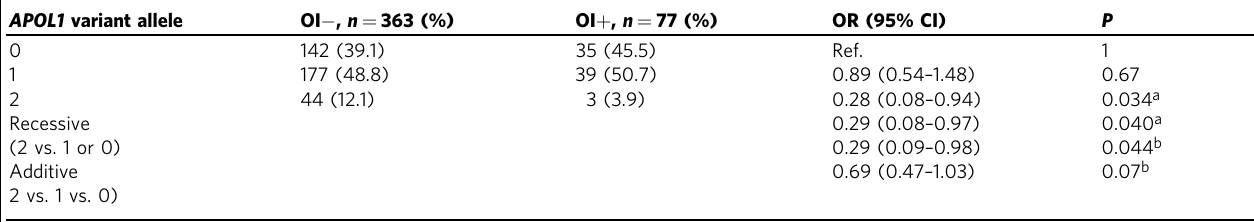
Table 2 Association of APOL1 G1 and G2 variant alleles with opportunistic infections in HIV-positive individuals in the ALIVE